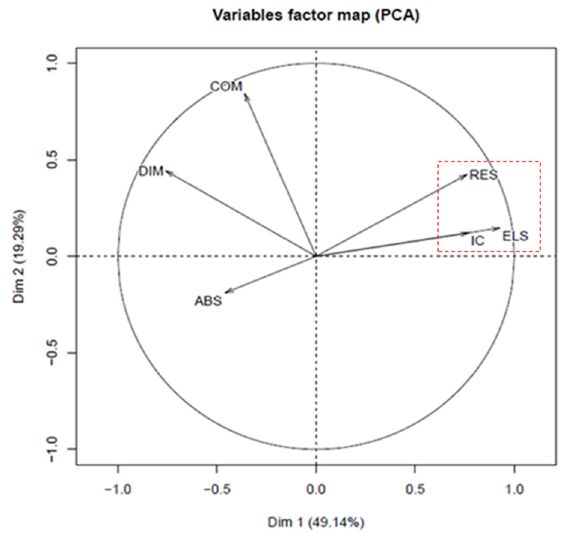
Figure 4 - Principal components analysis using 6 phenotypic variables for pineapple fiber quality: Resistance to traction (reS), elasticity module (eLS), and absorption (ABS), Crystallinity index (IC), fiber length (COM) and diameter of fiber (DIM). Factominer package in the r software (Development Core Team